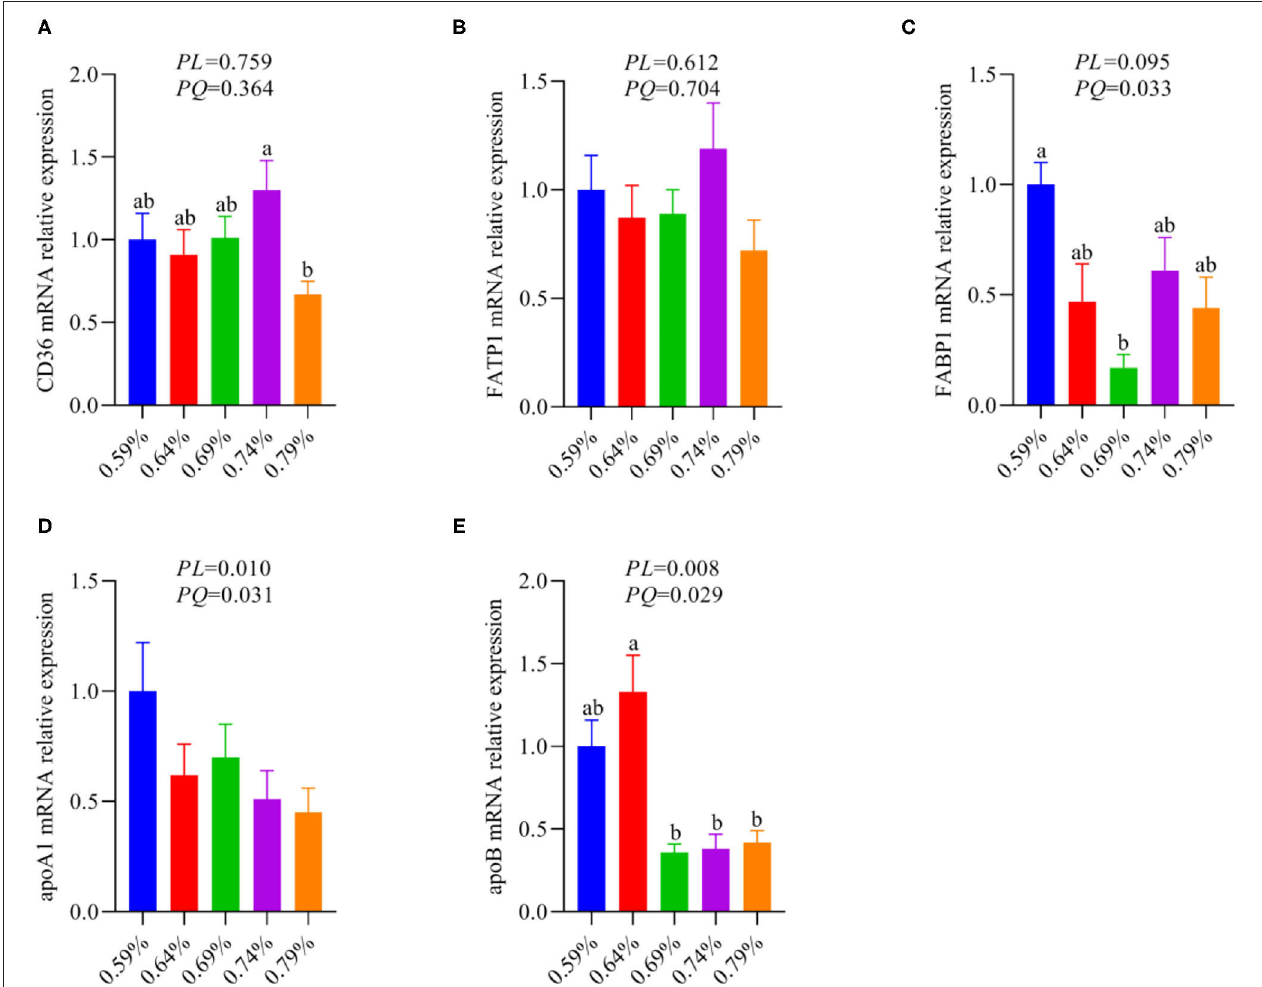
FIGURE 3 | The relative mRNA expression levels of fatty acid metabolism associated genes in the liver of laying hens ( n = 6–8). (A) CD36. (B) FATP1. (C) FABP1. (D) apoA1. (E) apoB. a,b Means with different superscripts within a column differ significantly ( P < 0.05).